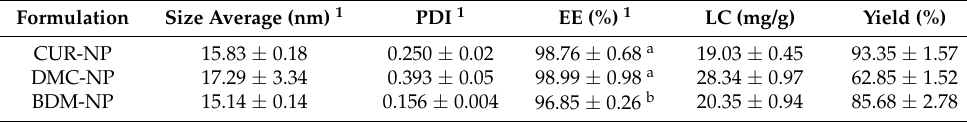
Table 1. Physical characteristics of CUR-, DMC-, and BDM-loaded